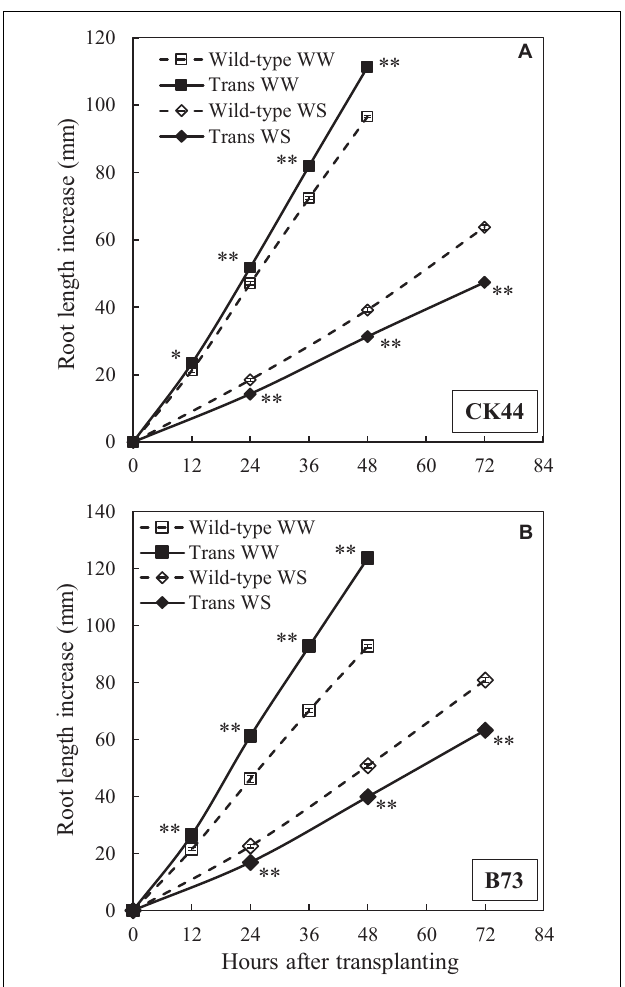
FIGURE 3 | Primary root elongation of CK44 (A) and B73 (B) oxalate oxidase transgenic (Trans) and wild-type lines after transplanting to well-watered (WW) or water-stressed (WS; –1.6 MPa) conditions. Data are means ± SE ( n = 10–32). Asterisks denote significant differences between the transgenic and wild-type lines ( t -test; ∗ P < 0.05; ∗∗ P < 0.01). The experiment was repeated three (CK44) or two (B73) times with similar results.